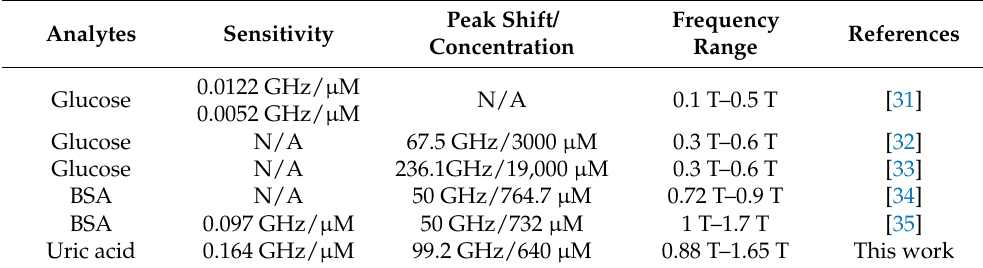
Table 1. Comparison of metamaterial sensing performance.